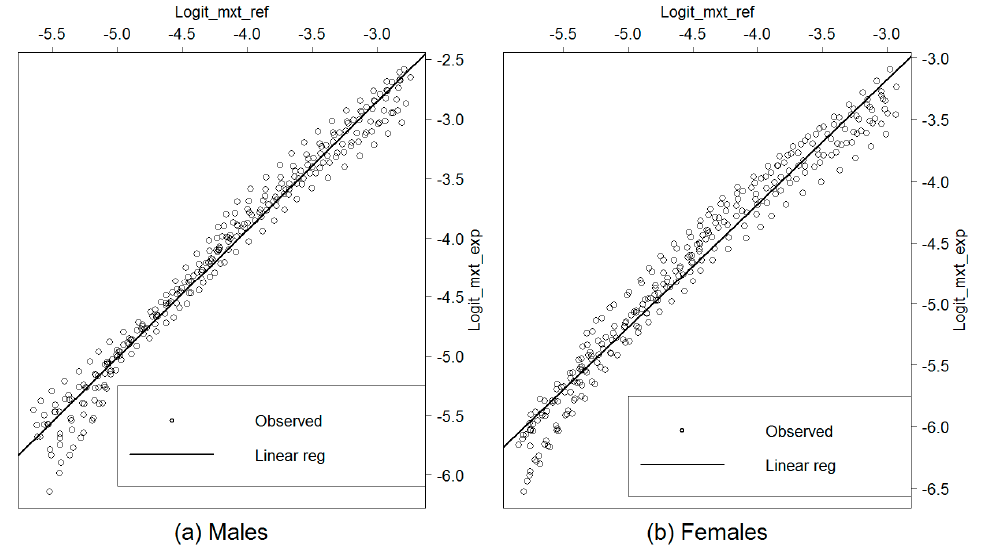
(cid:18) (cid:19) m ref x , t